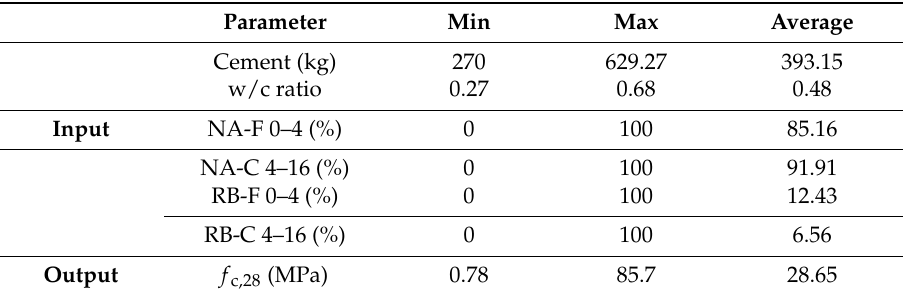
Table 2. Simple statistical analysis of the data in the experimental